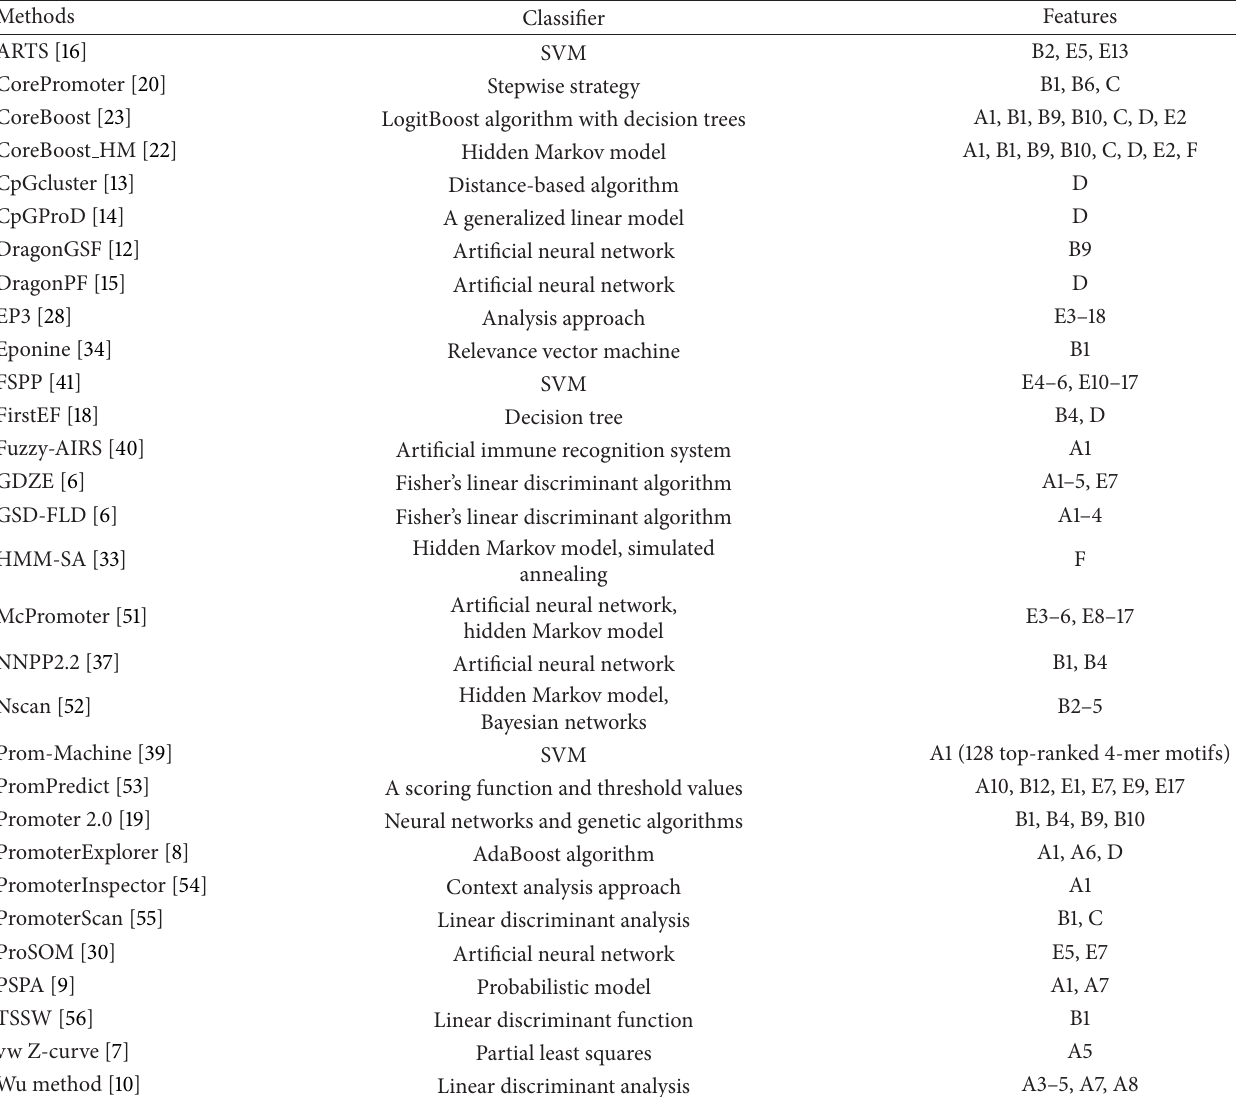
Table 2: Some representative prediction methods and classifiers with their used features. The informative features are explained in Table